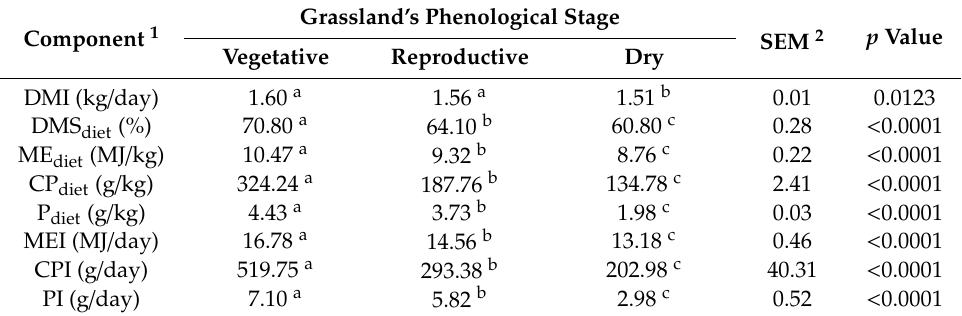
Table 3. Effect of annual grassland phenological stages on dry matter and nutrient intake in grazing sheep.